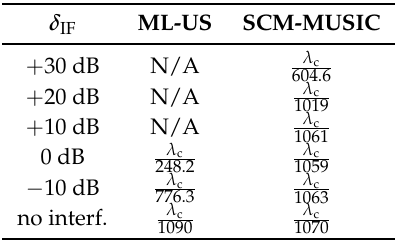
Table 3. RMSEs for scenarios with an interferer and SNR 0 = 20